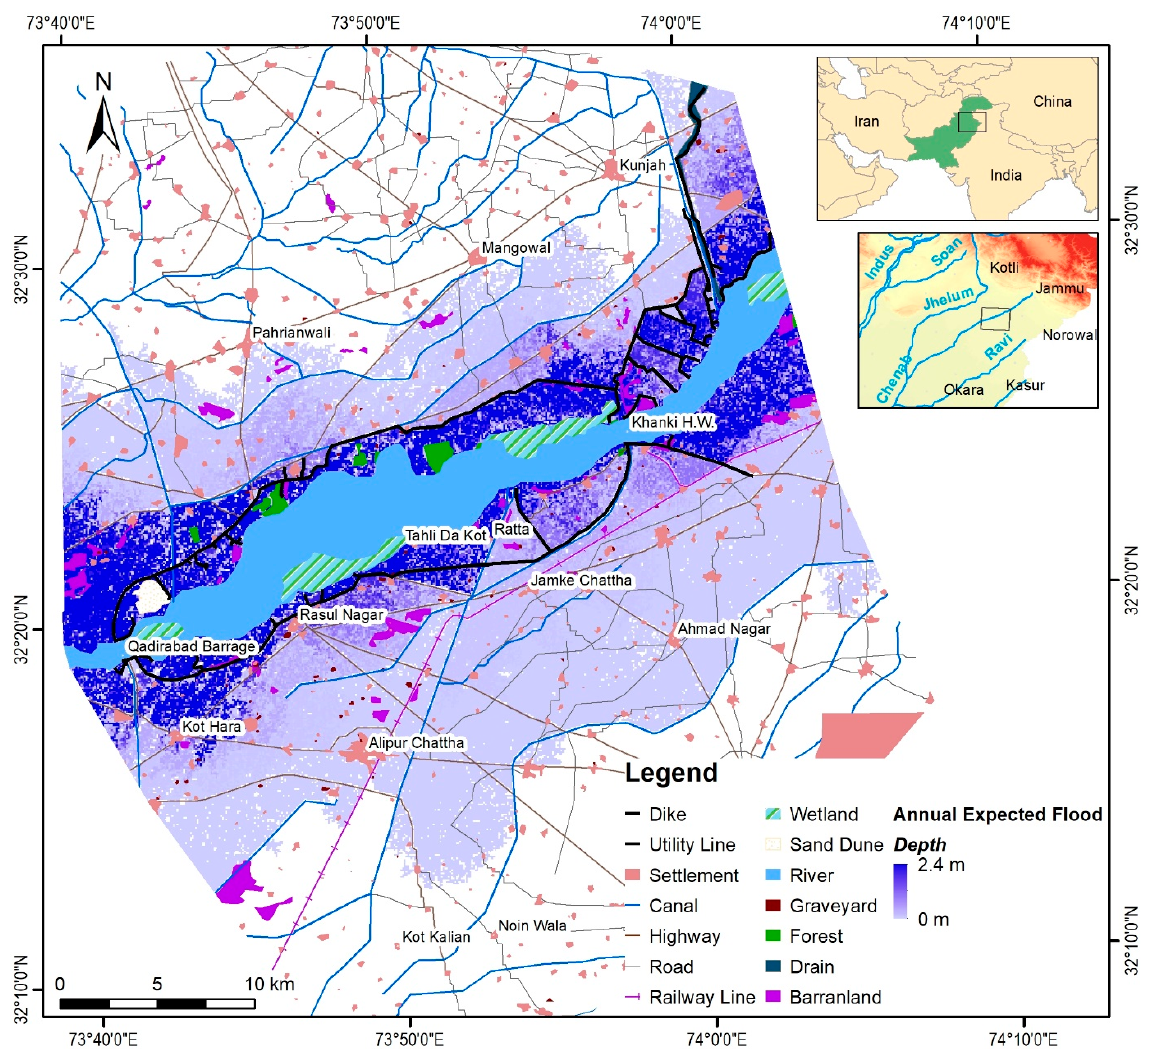
Figure 8. Expected flooding scenario showing weighted overlaid flood spreads and depths of different probabilities in the study area, from Khanki Headworks to Qadarabad Barrage, Chenab River, Pakistan.